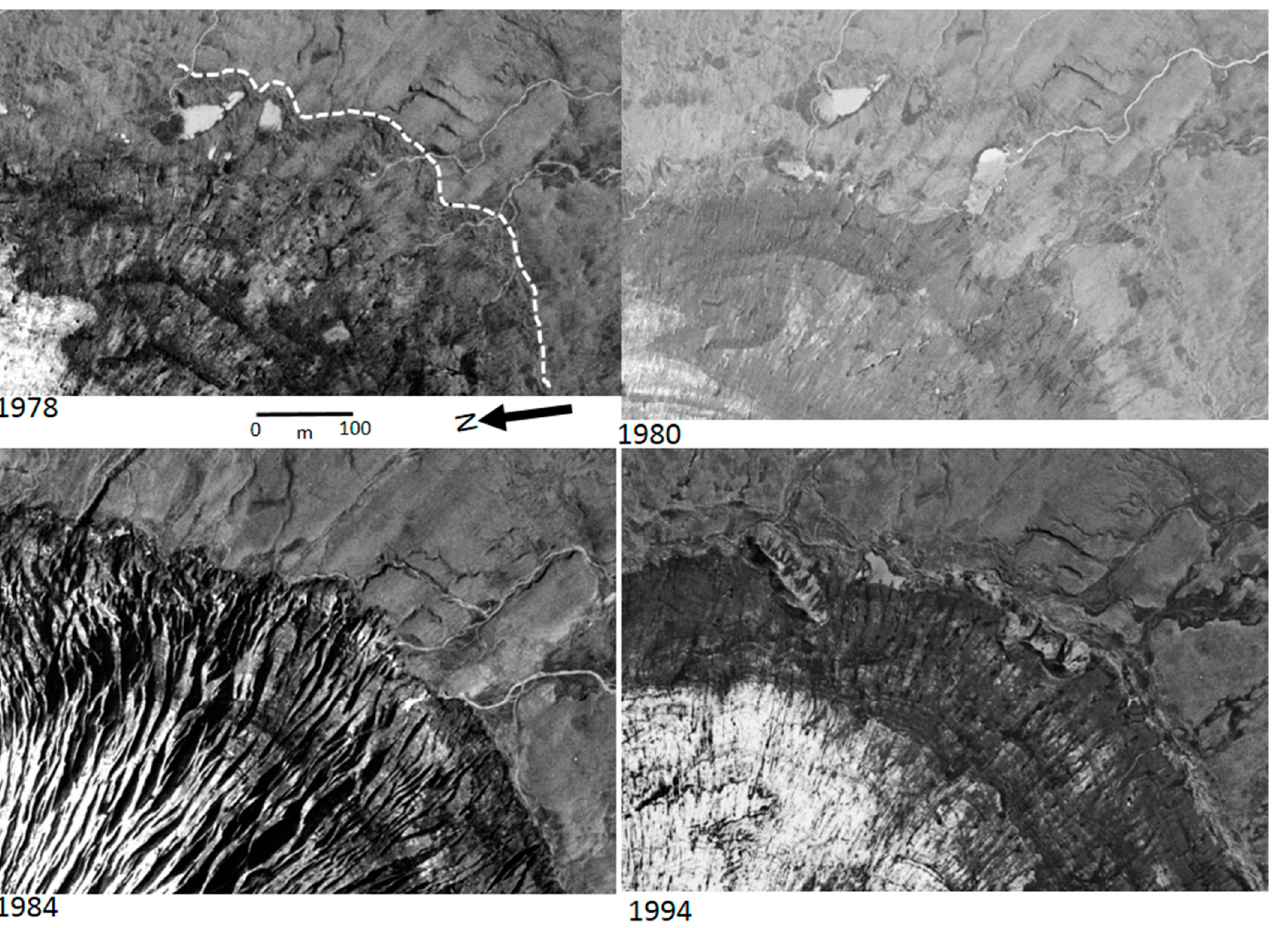
Figure 4. Aerial photograph extracts (Landmælingar Islands) of the same area of the Oldufellsjökull snout from the 1970–1990s period of glacier oscillation. Note the development and destruction of multiple push moraines as well as the emergence of a crevasse-fill ridge between 1984 and 1994 that mimics the localized arcuate crevasse patterns. The white dash line in 1978 demarcates the 1974 surge moraine.